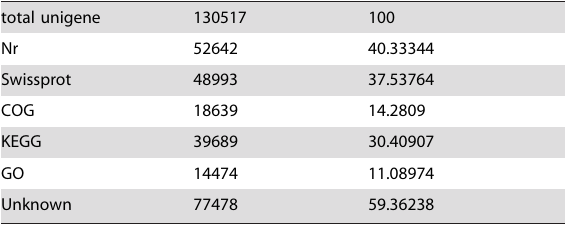
Table 2. All-in-one list of annotations.